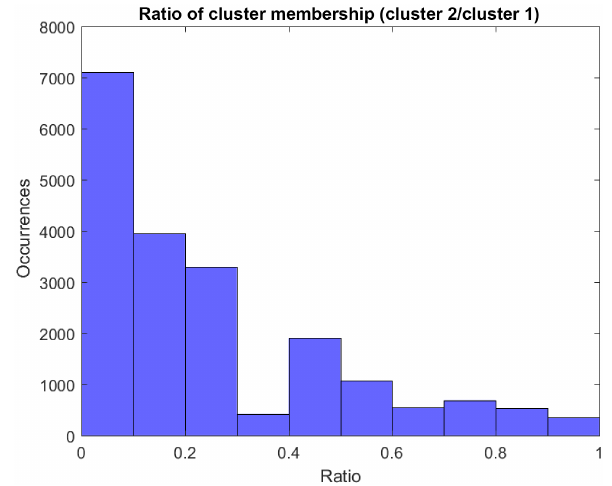
Figure 9. Histogram of the ratio of the number of members in the second most populous cluster (cluster 2) to those in the most popu- lous cluster (cluster